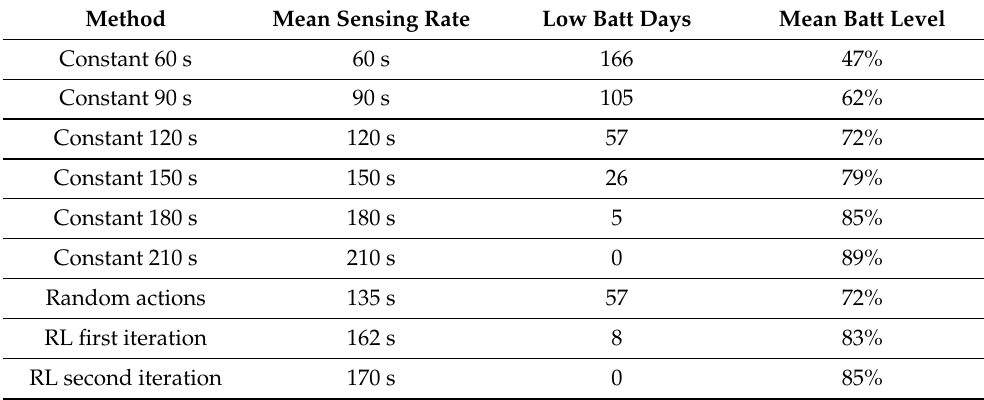
Figure 4. Battery levels and the selected sensing rates for the devices in RL based data stream management. Blue area represents min and max values of sensing rate, while the chart represent mean sensing rate value for the particular month. Table 3. Data stream management profiles used in the